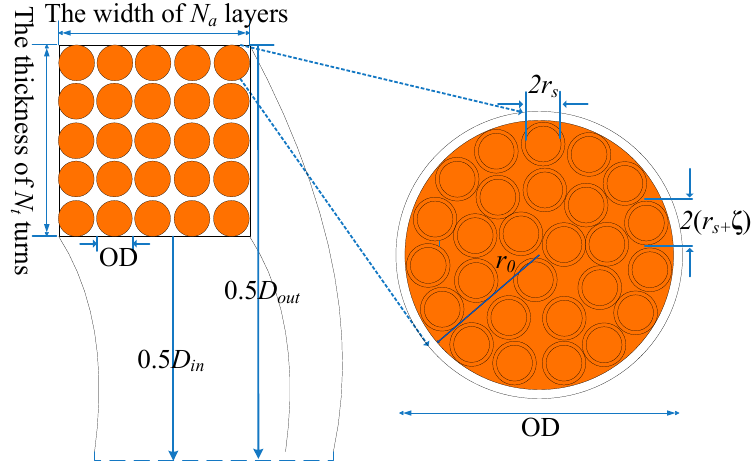
Figure 2. The driving coils’ cross section ( D in : Inner conductor loop, D out : Outer conductor loop, OD: Outer diameter) with multi-layer and multi-turn structure ( left ); cross sections of single turn with multi-strand wires ( right ).